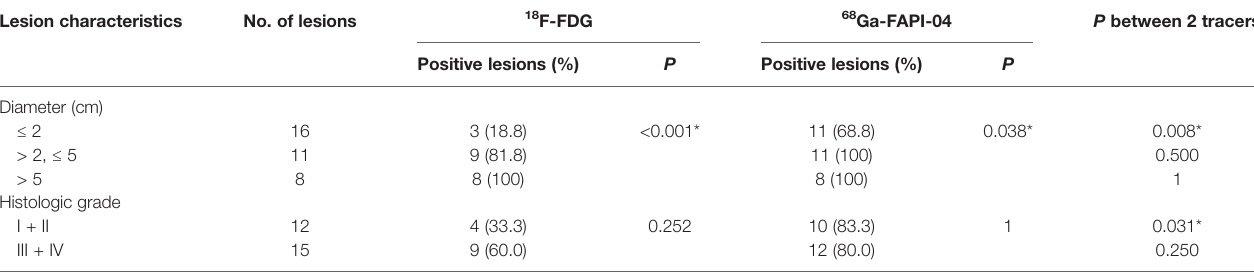
TABLE 3 | Sensitivities of 18 F-FDG and 68 Ga-FAPI-04 PET/CT in lesion-based analysis. Lesion characteristics